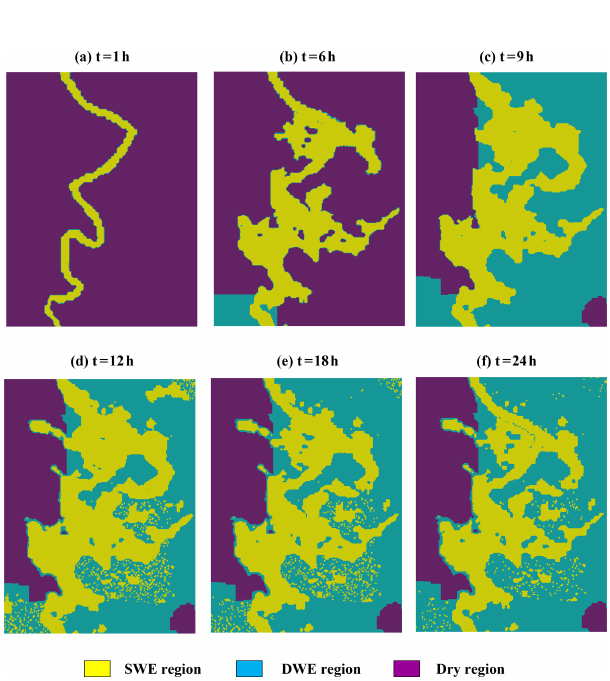
Figure 23. Evolution of coupling boundary.